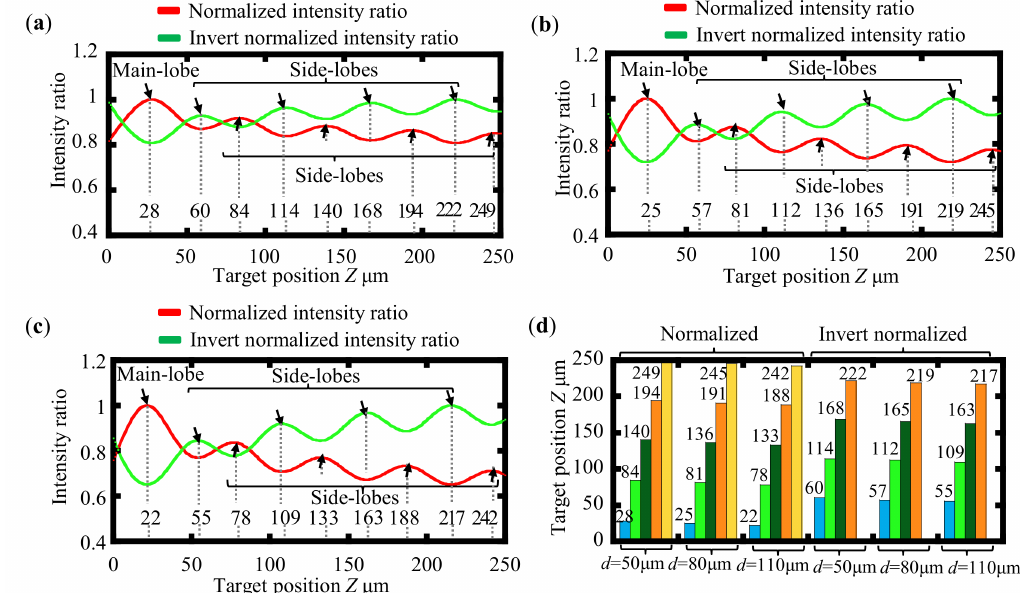
Figure 4. The main-lobes and the side-lobes extracted from the normalized intensity ratio and the invert normalized intensity ratio obtained at central wavelength λ = 1560 nm, together with side-lobe spacing and main-lobe to side-lobe spacing with target positions ranging from 0 to 250 µ m and defocus d ranging 50 µ m to 110 µ m. ( a ) Main-lobe and side-lobes obtained from normalized and invert normalized intensity ratio at central wavelength with d = 50 µ m. ( b ) Main-lobe and side-lobes obtained from normalized and invert normalized intensity ratio at central wavelength with d = 80 µ m. ( c ) Main-lobe and side-lobes obtained from normalized and invert normalized intensity ratio at central wavelength with d = 110 µ m. ( d ) The side-lobe spacing and main-lobe to side-lobe spacing at central wavelength with d = 50 µ m, 80 µ m, and 110 µ